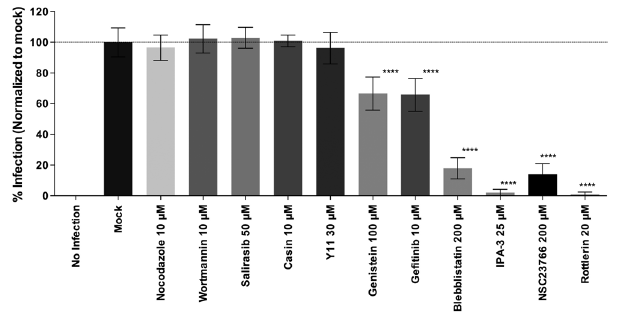
Figure 9. Cellular requirements for IPNV infection. IPNV infection of CHSE-214 cells was carried out in the presence of inhibitors of structural and functional cell components: nocodazole (10 μ M), wortmannin (10 μ M), salirasib (50 μ M), casin (10 μ M), Y11 (30 μ M), genistein (100 μ M) gefitinib (10 μ M), blebbistatin (200 μ M), 3-indole propionic acid (IPA-3 25 μ M), NSC23766 (200 μ M), rottlerin (20 μ M), or no infection. CHSE-214 cells were propagated at 70–80% confluence in 24-well plates with round glass coverslips. IPNV was inoculated at an MOI of 1 for 1 h in the presence of the respective inhibitor. After 12 h of incubation at 20 °C, cells were processed by indirect immunofluorescence (IFI). Imaging of fixed slides was performed with an Olympus Spinning Disk IX81 microscope, and 250 cells were counted at each condition. Number of VP2/VP3-expressing cells is shown as a percentage, normalized to mock